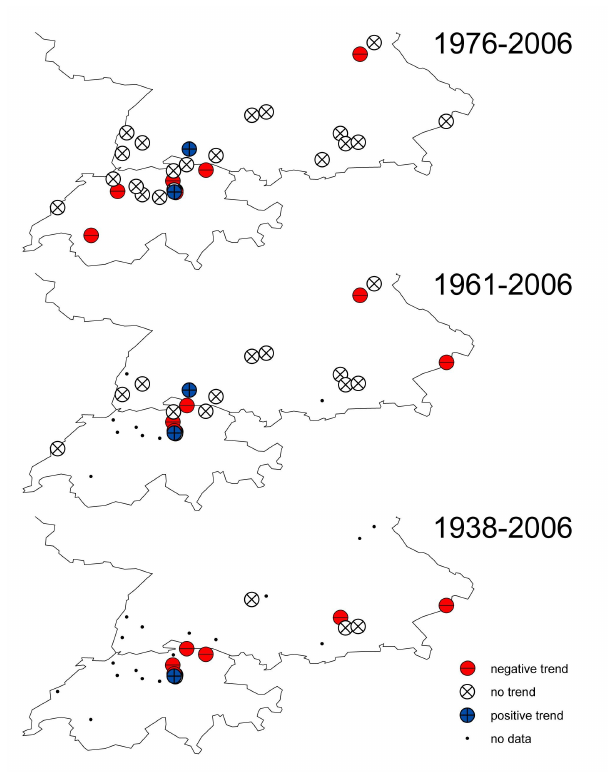
Fig. 6. Observed groundwater trends at the studied sites in northern Switzerland and southern Germany in three different time